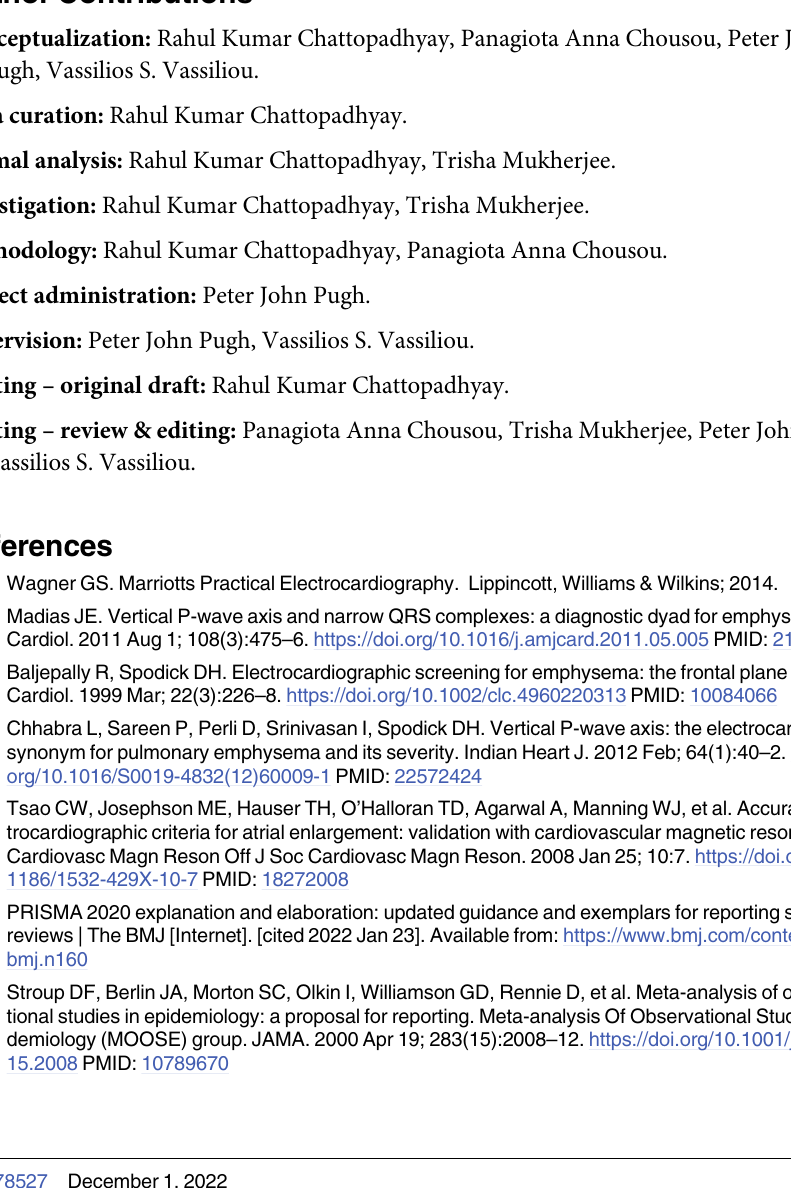
S1 Fig. Newcastle-Ottawa scale quality scores for each study included in the meta-analysis. S2 Fig. Forest plot of sensitivity analysis. Sensitivity analysis demonstrating continued asso- ciation of P-wave analysis despite exclusion of Rangel et